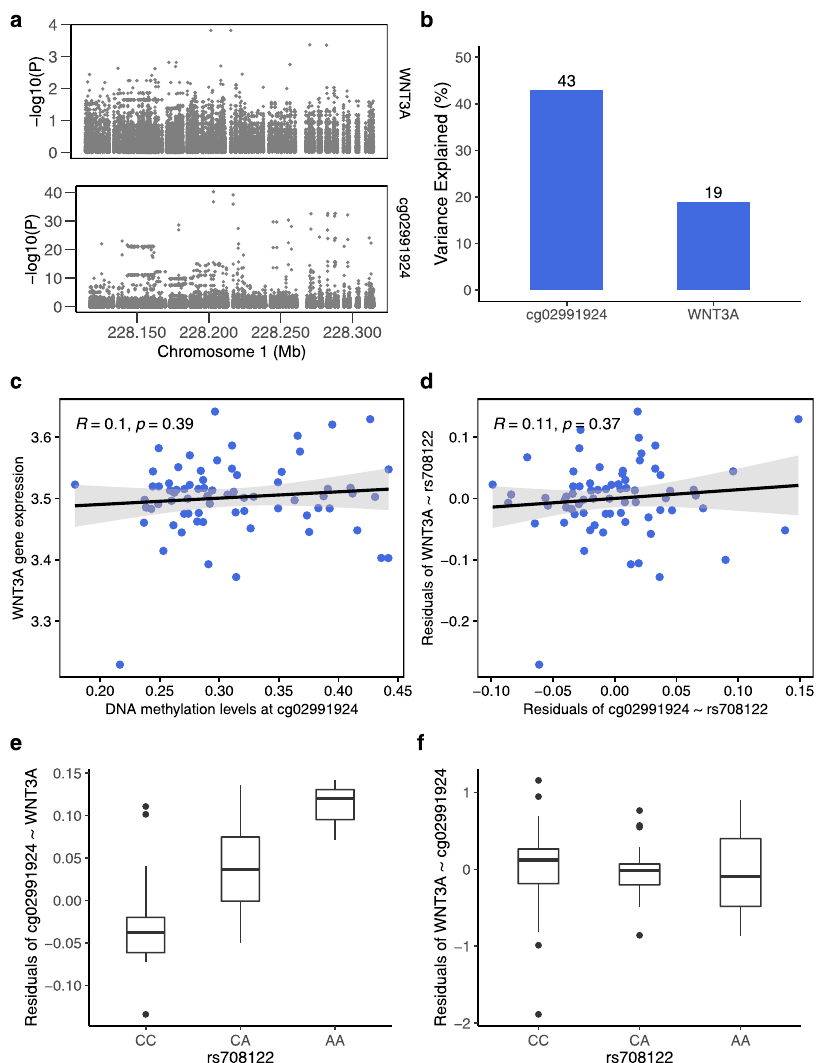
Fig. 4 Direction of the relationship between birthweight-associated SNP, DNA methylation and WNT3A gene expression in placenta. a Association between all SNPs 100 kb up- and downstream of the birthweight GWAS SNP rs708122 and WNT3A gene expression (upper panel) and DNA methylation at cg02991924 (lower panel). The strongest association was found for the index SNP or its nearest linkage disequilibrium (LD) proxies. b rs708122 accounts for higher variance in DNA methylation than in WNT3A expression based on MR Steiger test. c , d Error bands in gray represent standard error of the mean and P is based on a two-sided Spearman correlation test. DNA methylation and WNT3A expression were not correlated. e , f Box plots indicate median (middle line), 25th, 75th percentile (box) and 5th and 95th percentile (whiskers) as well as outliers (single points). N = 71 individuals. rs708122 was associated with DNA methylation after regressing out WNT3A expression ( e ) (Kruskal Wallis test P = 3.06 × 10 − 7 ) but was not associated with residuals of WNT3A after regressing out DNA methylation ( f ) (Kruskal Wallis test P =